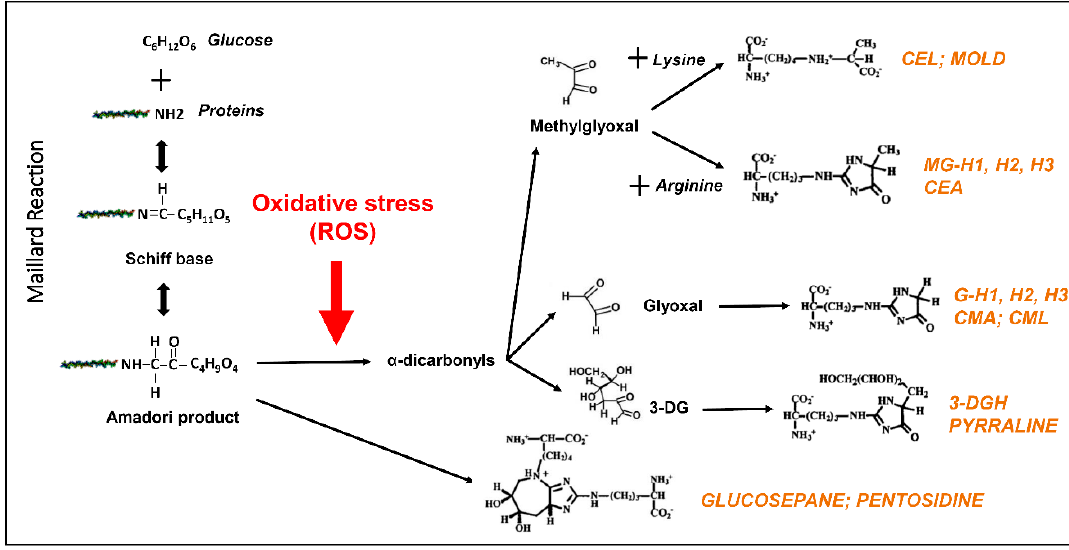
Figure 1. Production of advanced glycation end-products (AGEs) is accelerated under oxidative stress. AGEs are derived from sugars or dicarbonyls generated from carbohydrate metabolism through different chemical routes including the Maillard reaction. The excess of reactive oxidative species (ROS) promotes the production of different AGEs from dicarbonyls (methylglyoxal, glyoxal, or 3-deoxyglucosone (3-DG). AGEs are highlighted in orange. CML: N ε -(carboxymethyl)-lysine; CMA: N ε -(carboxymethyl)-arginine; 3-DG: 3-deoxyglucosone; 3-DGH: GH-1,2,3: Glyoxal-derived hydroimidazolone; MGH-1,2,3: Methylglyoxal-derived hydroimidazolone; CEL: N ε -(carboxyethyl)-lysine; CEA: N ε -(carboxyethyl)-arginine; MOLD: Methylglyoxal-derived lysine dimer. AGEs are accumulated throughout the body upon aging and particularly in diabetic patients.